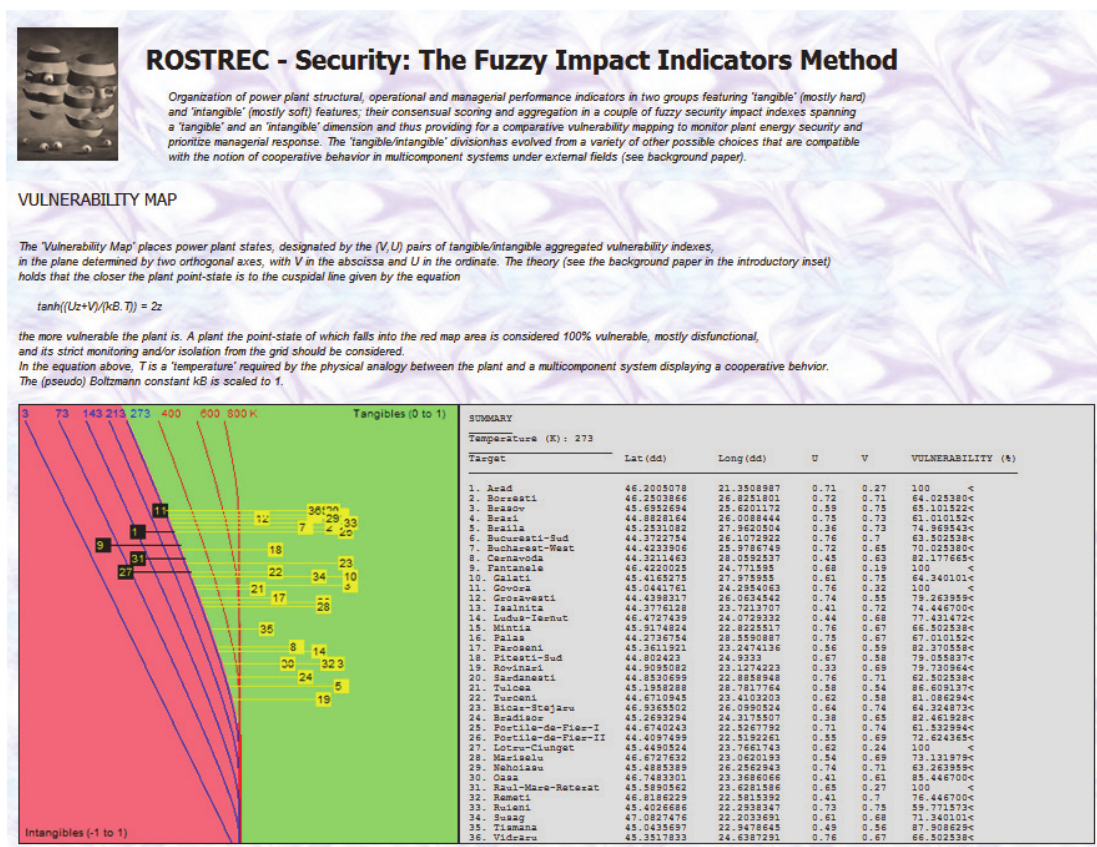
Figure 6 . A vulnerability map of the power generation plants in a